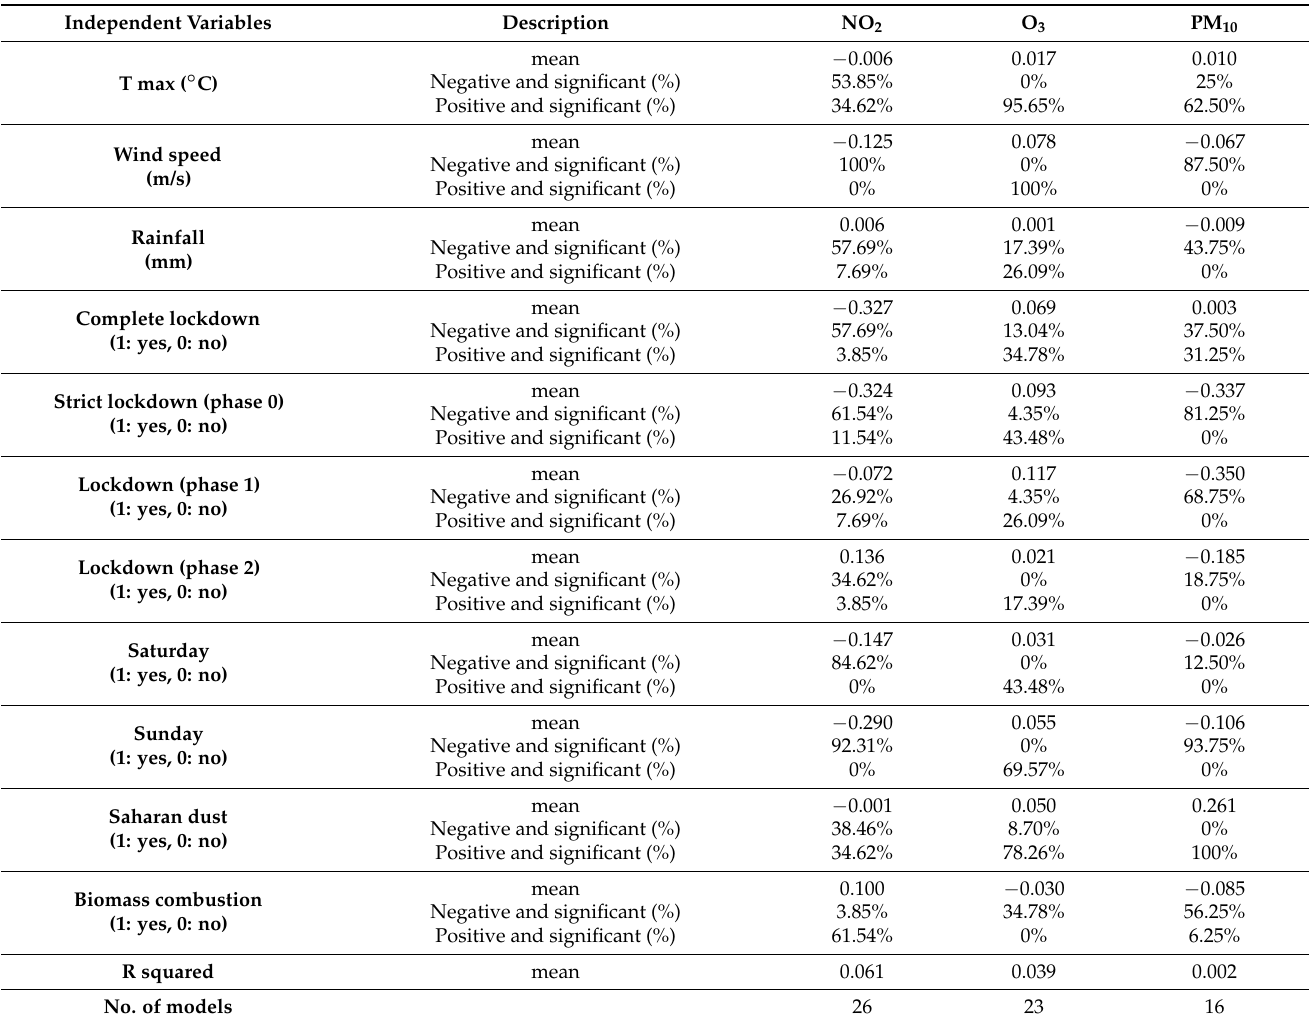
Table 1. Regression results from pollutants. Columns 3 to 5 display the estimated mean coefficients between the regression models of each independent variable (independent variable column) relative to each dependent variable (pollutant) in southeastern